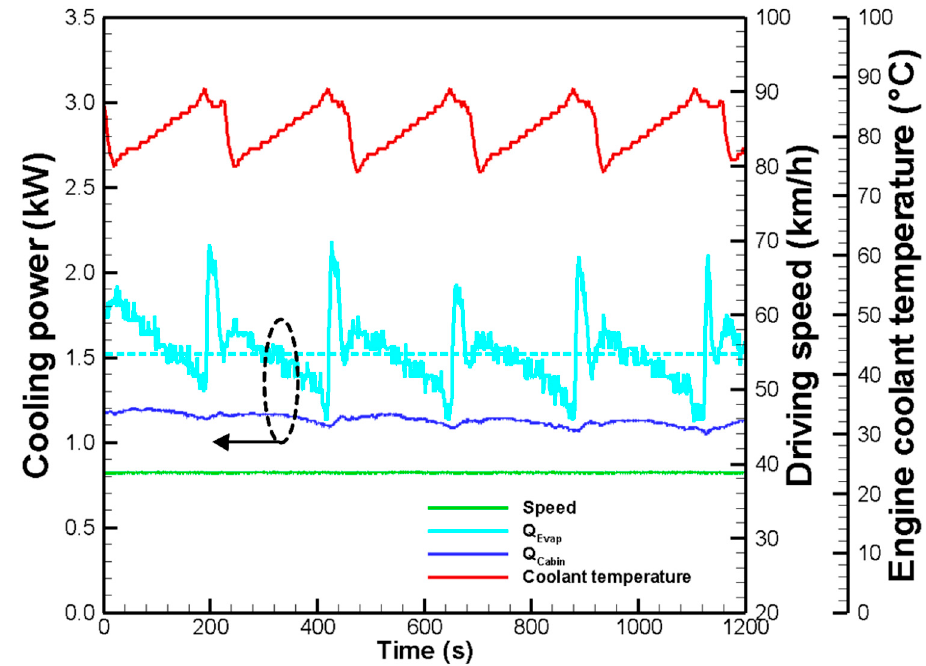
Figure 5. Wind tunnel test (Test no. 1) result of the prototype at constant vehicle speed and 30 °C ambient temperature.